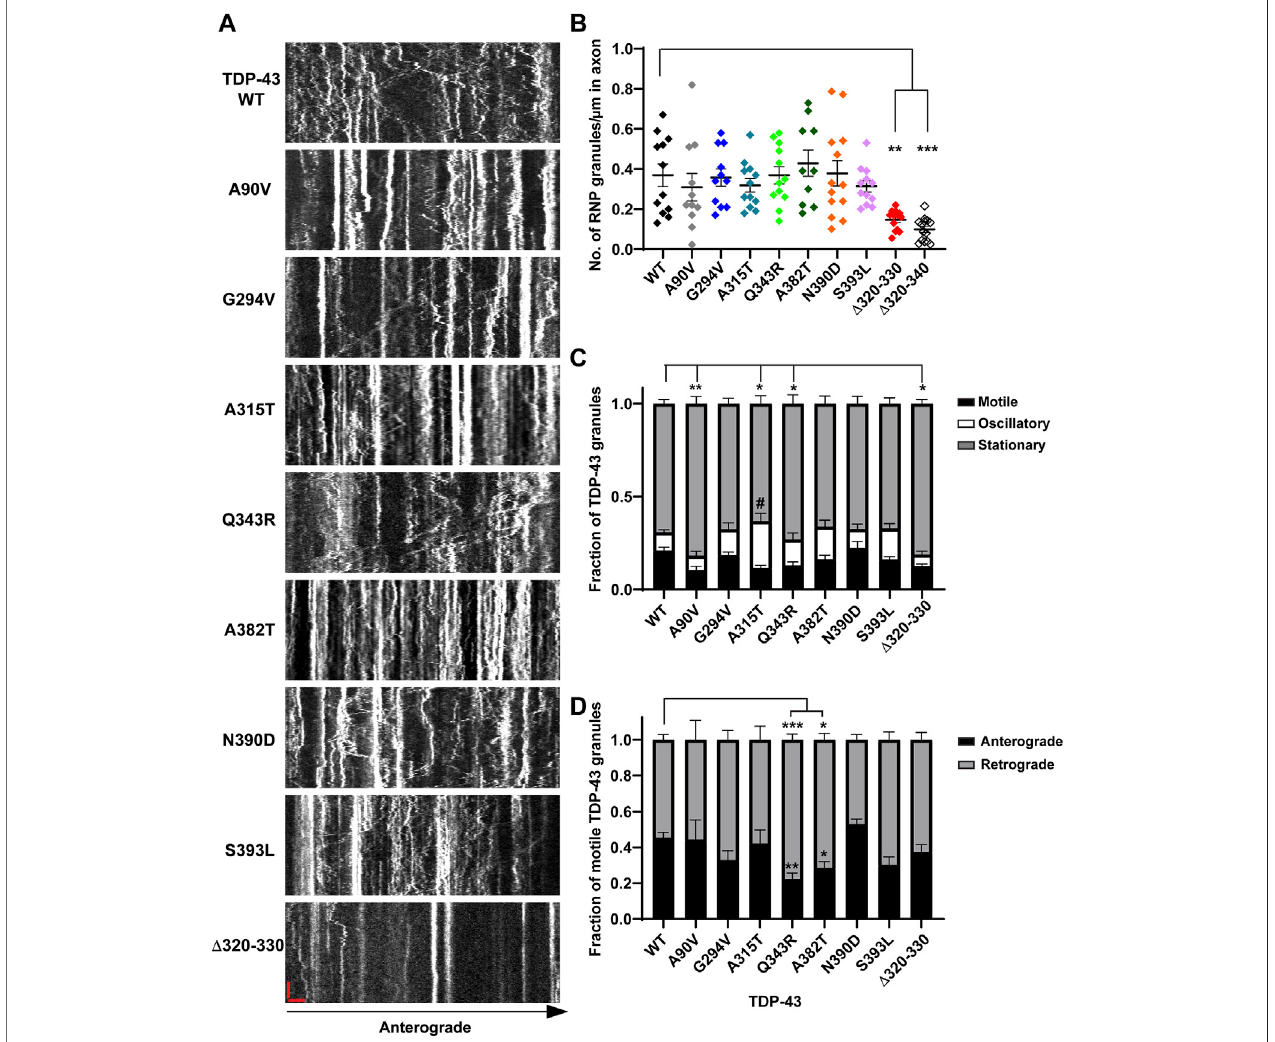
FIGURE 1 | Neuronal RNP granules composed of ALS-linked TDP-43 mutants or TDP-43 Δ 320-330 exhibit reduced motility. (A) Axons of primary cortical neurons (DIV7-10)expressingGFPtaggedWTormutantTDP-43wereimagedusinglive-cellspinningdiskconfocalmicroscopy.RepresentativekymographsofGFPtaggedTDP-43 WTormutantRNPgranulesareshown.Inthekymographs,theretrogradedirection(towardstheSoma)istotheleftandtheanterogradedirectionistotheright.Thescalebar (horizontalredline)correspondsto3 μ m( x axis)andtimescale(verticalredline)correspondsto50 s( y axis). (B) ThenumberofTDP-43RNPgranulesper μ mlengthof axonforTDP-43WTanddifferentmutantsisshown.TDP-43 Δ 320-330and Δ 320-340lackpartorallofthe α -helicaldomain,respectively,andserveascontrolsexpectedto substantiallyreducephaseseparation.Foreachcondition, n =10 – 14neuronswereanalyzedfrom3independentexperiments( N =3). (C) FractionofTDP-43WTormutant RNP granules that are stationary,oscillatory,ormotilein the axon; motile puncta ≥ 10 μ m net displacement in5 min. (D) The fraction ofmotile TDP-43RNPgranulesfor WT and mutants (shown as black bars in Figure 1C ), is further categorized byretrograde or anterograde motility. For each condition, n = 12 – 14 neurons were analyzed from 3 independentexperiments( N =3).Errorbarsrepresentstandarderrormean.OnewayANOVA(Kruskal – WallistestwithDunn ’